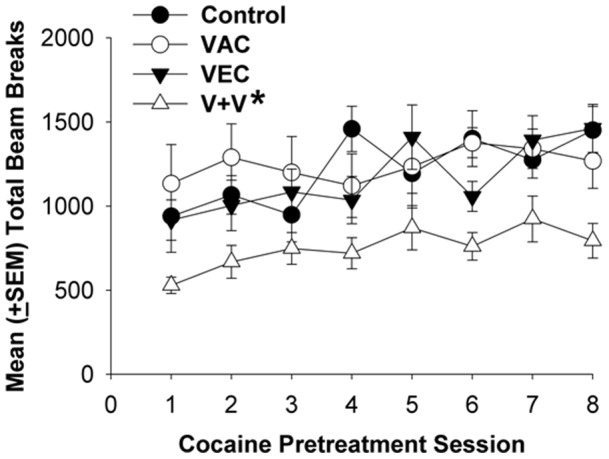
Mean daily beam breaks after cocaine during training phase.Data represent rat locomotor activity in 8 daily 45 min sessions immediately following cocaine injections. Statistical significance: * significantly lower locomotor activity in VEC+VAC group compared to all other groups (p<0.05); † significantly greater locomotor activity on the final training-phase day compared to the first day (p<0.05).